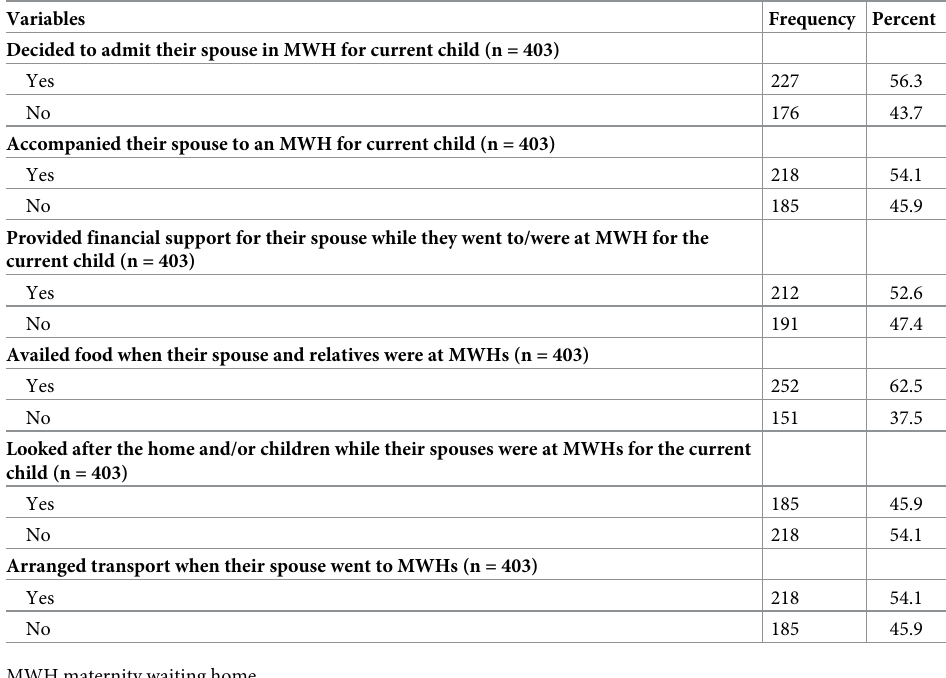
Table 4. Distribution of men’s involvement in MWH utilization in North Achefer district, 2018. Variables